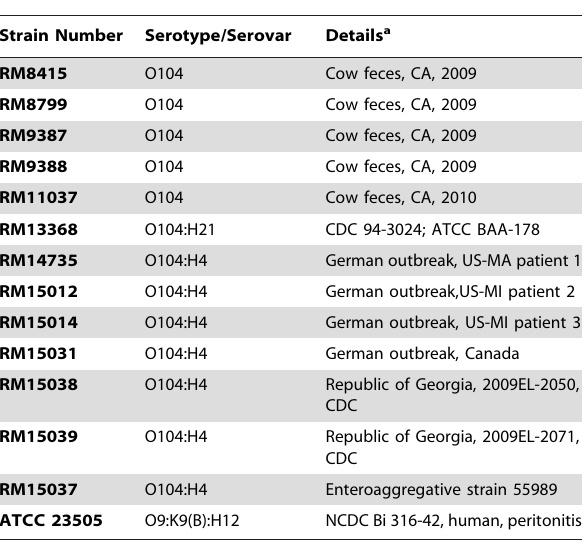
Table 1. E. coli strains sensitive to AvR2-O104.1.